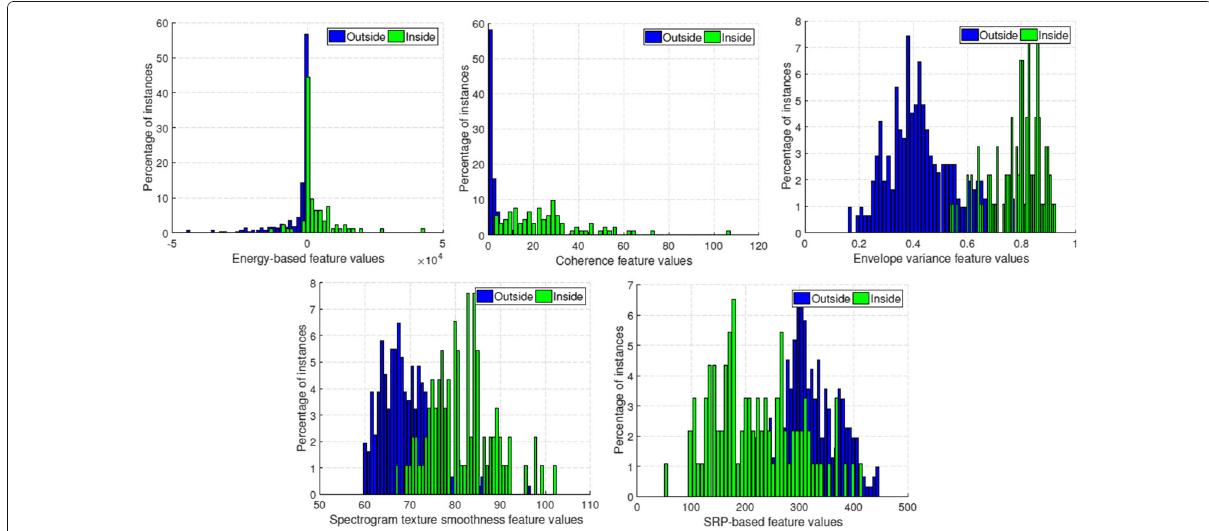
Fig. 3 Histograms of the five hand-crafted scalar features of Section 5.1, demonstrating their ability to discriminate room-inside vs. room-outside speech. Histograms are computed over the development set of the simulated dataset of Section 7.1, for the case of the smart home bedroom (see also Fig. 1). Upper row, left-to-right: energy-based feature (Section 5.1.1), coherence feature (Section 5.1.2), and envelope variance one (Section 5.1.3). Lower row, left-to-right: spectrogram texture smoothness feature (Section 5.1.4) and SRP-based one (Section